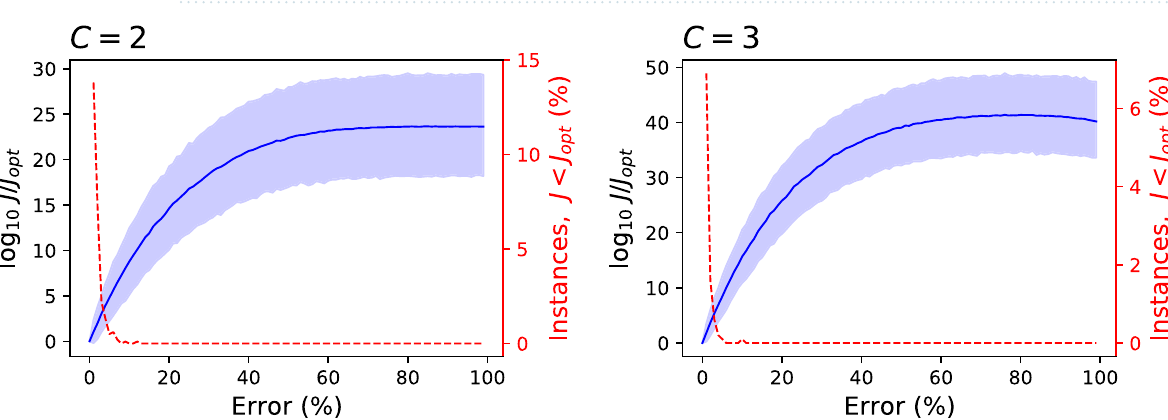
Figure 3. Significance of the clustering for synthetic data and C = 3 . Meaning of lines and axes is the same as in Fig. 2. See main text, and specifically Eq. (5), for details on the reconstruction of the synthetic data.